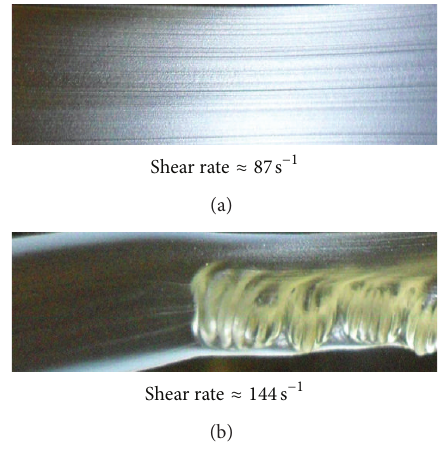
Figure 10: Extrudate of HDPE-C15A at apparent shear rate of (a) 87 s −1 (stick-slip region) and (b) 144s −1 (gross-melt fracture region).